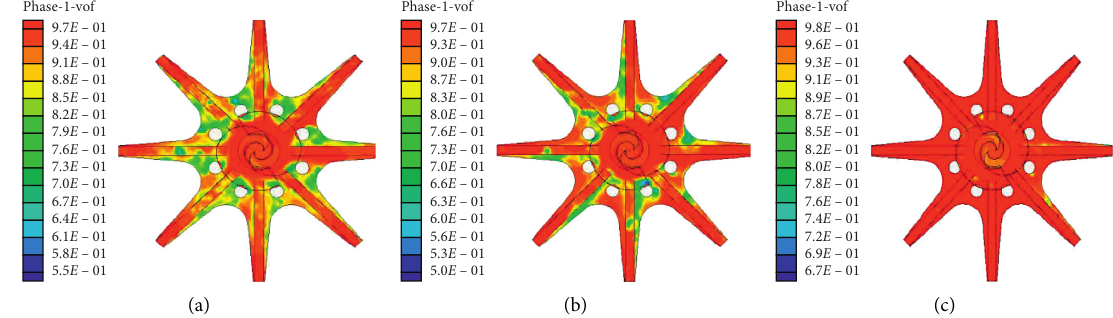
Figure 13: Liquid phase distribution under different flow rates. (a) Q